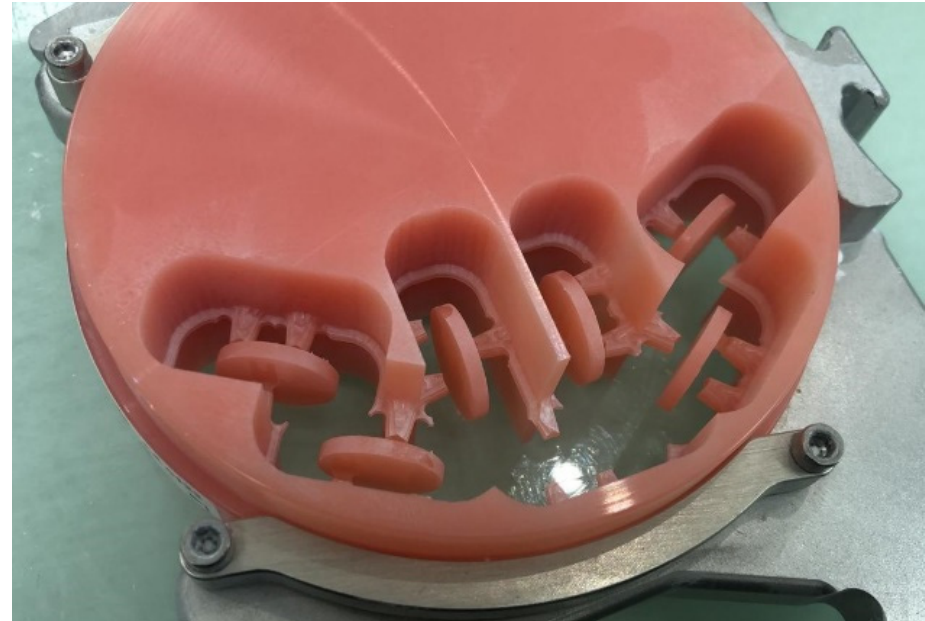
Figure 2. Specimens prepared by CAD/CAM subtractive manufacturing technique (Milling).